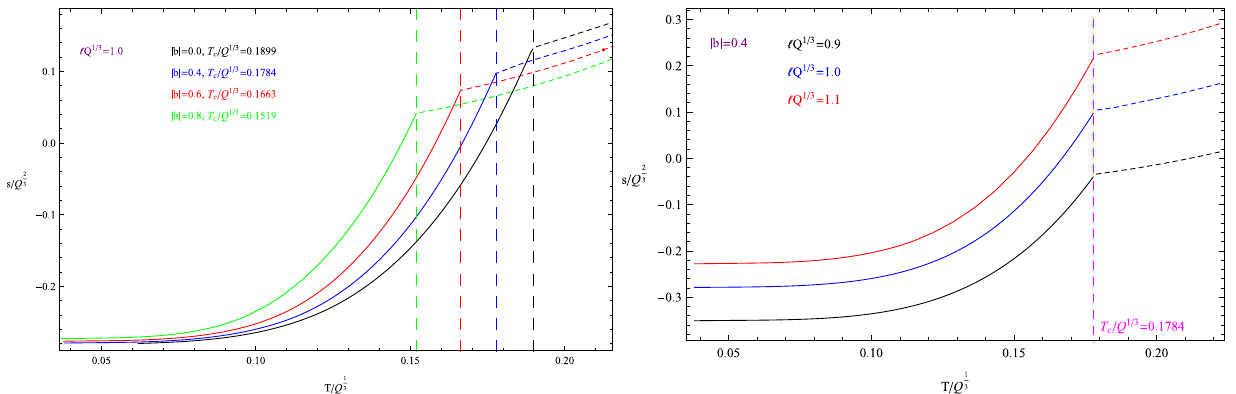
Fig. 6 The operator (cid:8) ˆ O + (cid:9) with respect to the temperature T for dif- ferent LNE parameter b (right plot). The black line is for | b | = 0 . 0, the blue line is for | b | = 0 . 4 , the red line is for | b | = 0 . 6, and green line